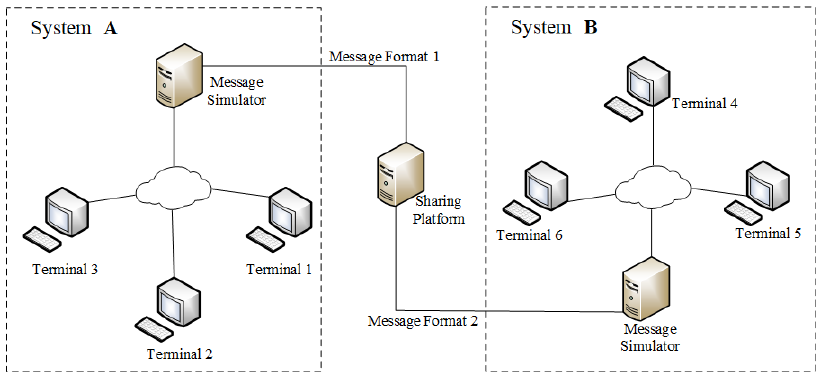
Figure 12. Demonstration scene of heterogeneous information sharing.